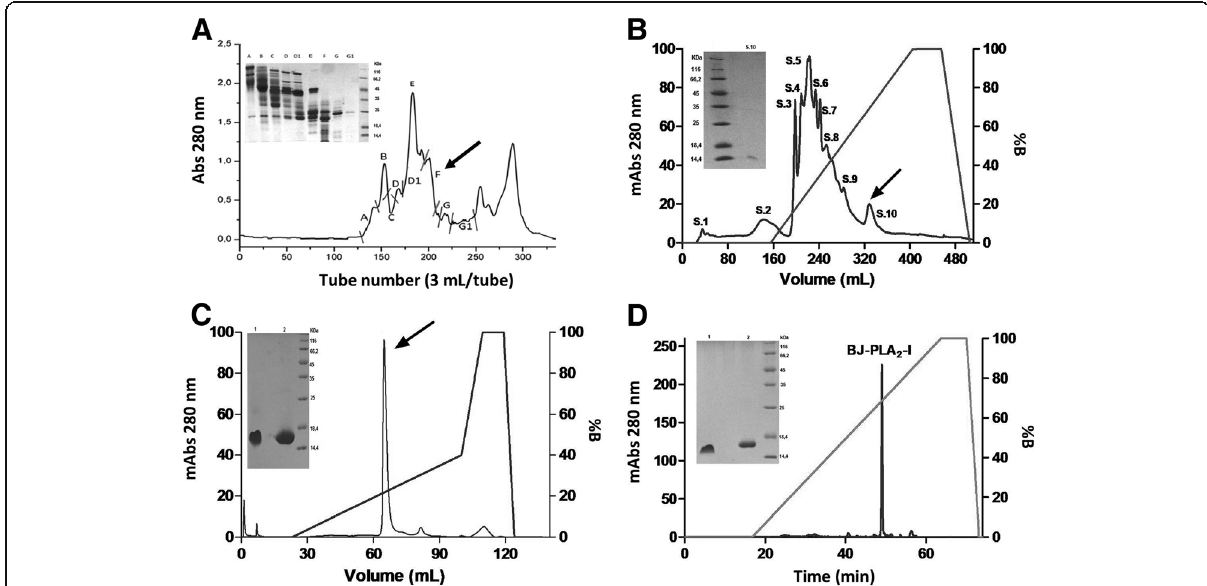
Fig. 1 Isolation of BJ-PLA 2 -I from B. jararaca venom. a Chromatographic profile of Bothrops jararaca venom (200 mg) on Sephacryl S-200 column: Elution was carried out with 50 mM Ambic, pH 8.0. Inset, 12% SDS-PAGE of the fractions from A to G1 in non-reducing conditions. b Chromatographic profile of fraction F (~50 mg) on a Source 15Q column: Elution was carried out with 20 mM Tris-HCl, pH 8.0, and a linear concentration gradient of NaCl (from 0 to 1 M). Inset, 12% SDS-PAGE of the fraction of interest (arrow) in non-reducing conditions. c Chromatographic profile of fraction S.10 (~1.2 mg) on a Mono Q 5/50 GL column: Elution was carried out with 50 mM Ambic, pH 8.0, and a linear concentration gradient of NaCl (from 0 to 1 M). Inset, 12% SDS-PAGE of the fraction of interest (arrow) in non-reducing (1) and reducing (2) conditions. d Chromatographic profile of BJ-PLA 2 -I (~200 μ g) on a C18 reversed-phase column using a HPLC system: The column was previously equilibrated with solution A (0.1% TFA), and elution was performed at flow rate of 1 mL/min with a linear concentration gradient of solution B (70% acetonitrile and 0.1% TFA). Inset, 12% SDS-PAGE of BJ-PLA 2 -I in non-reducing (1) or reducing (2) conditions